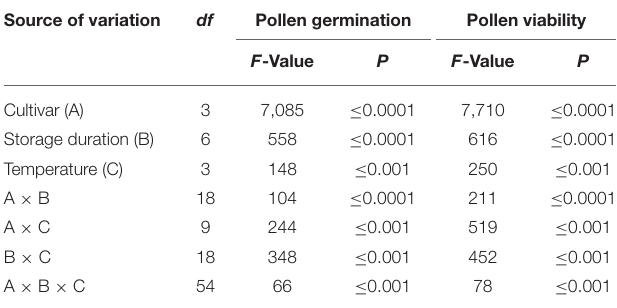
TABLE 3 | Mixed factorial design showing the effect of storage temperature and storage duration on pollen germination and viability of four Serbian autochthon apple